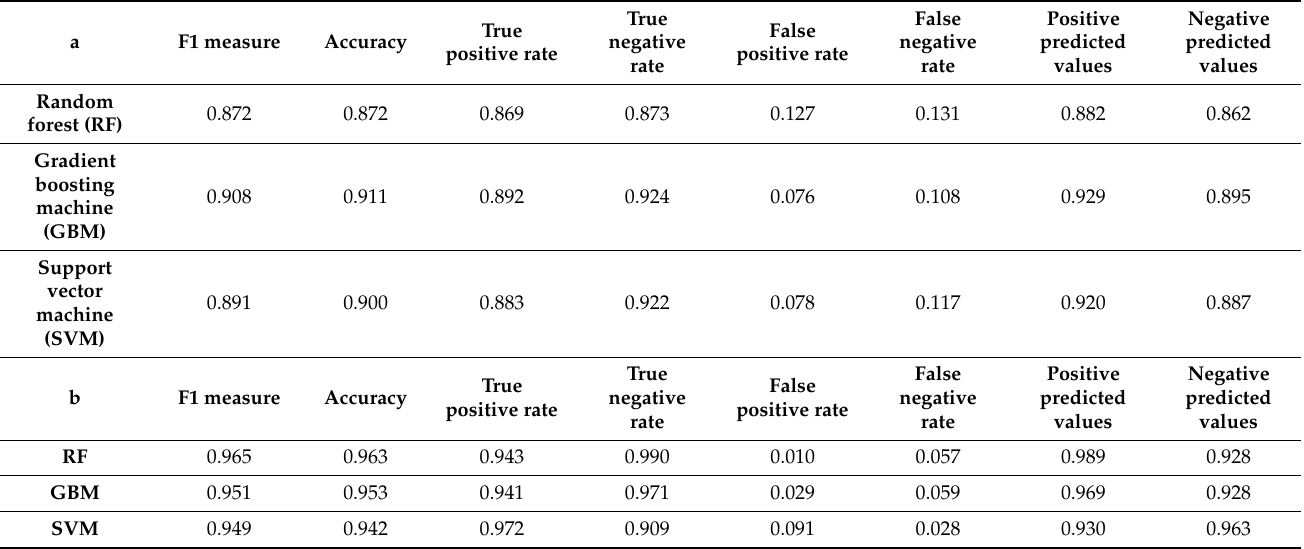
Table 1. Performance metrics of each model: ( a ) waste-tissue classification results; ( b ) ragged–not ragged classification results.